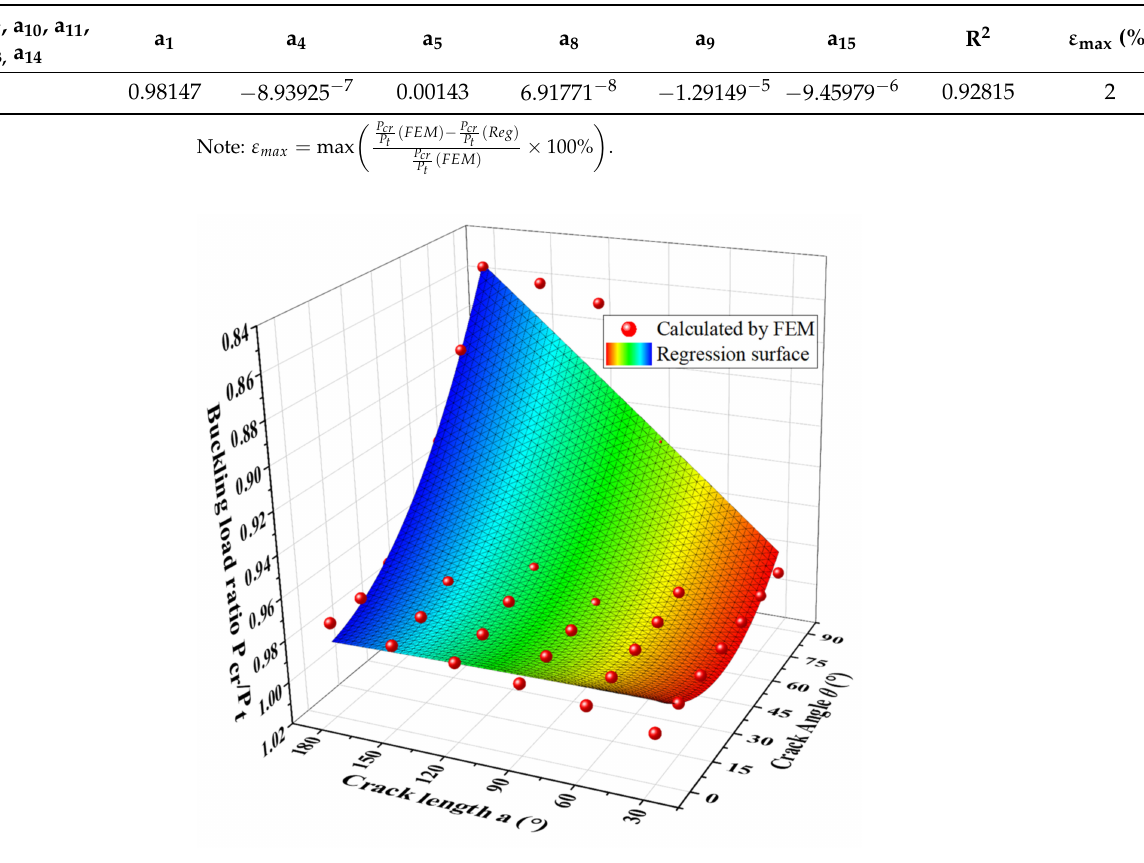
Figure 18. Relation of elastic buckling of cracked cylindrical shell with clamped support ( L / R = 20, R / T = 25).